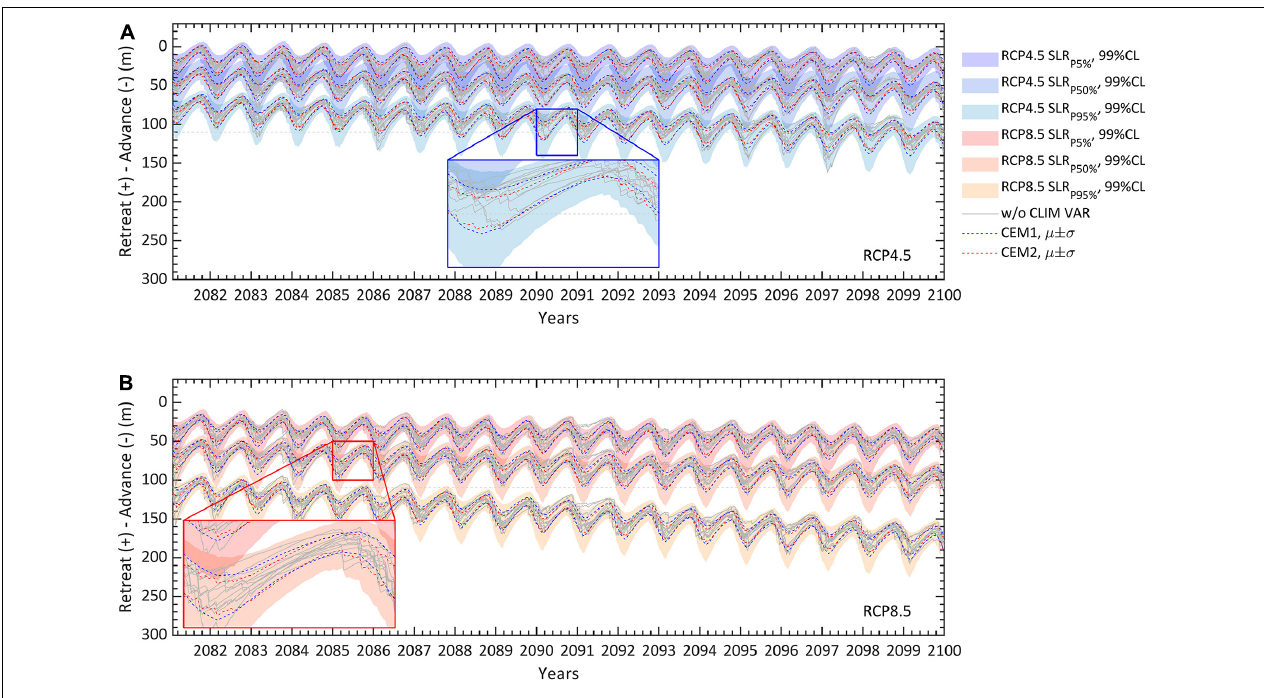
FIGURE 4 | Shoreline evolution projections for the period 2081–2100 in San Lorenzo Beach. Shoreline position retreat (positive values) and advance (negative values) with respect to the present position. Coloured shaded bands and dashed lines are related to the 72,000 simulations of SP1 generated for 2 RCPs (RCP4.5 and RCP8.5, A,B , respectively), 6 GCMs (ACCESS1.0, CMCC-CC, CNRM-CM5, HadGEM2-ES, IPSL-CM5A-MR and MIROC5), 3 SLR percentiles (5, 50, and 95th), climate variability (1,000 multivariate realisations per each RCP-GCM) and 2 CEMs. The 72 simulations of SP3 (without considering climate variability) are represented by the grey solid lines. The grey dashed line represents the threshold beyond which the beach would have